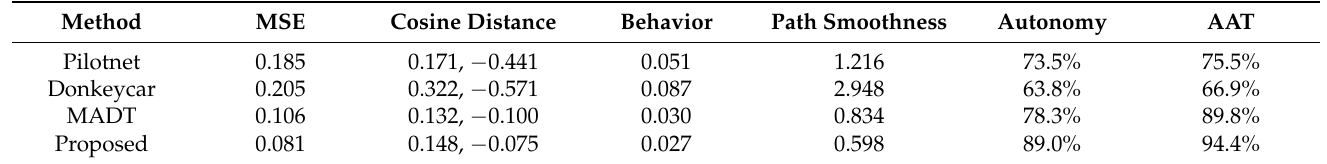
Table 2. Quantitative results of the experimentation on the scale